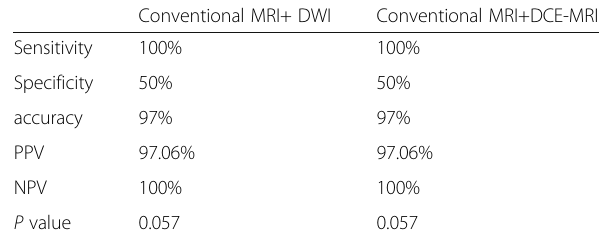
Table 4 Sensitivity, specificity, PPV, NPV, and accuracy of (MRI+DWI) compared to (conventional MRI+